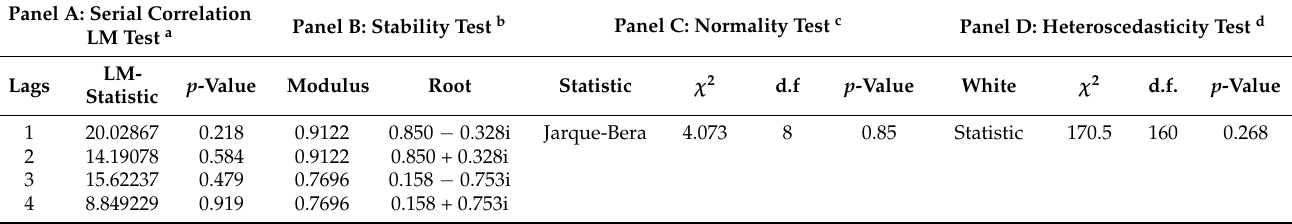
Table 3. The VAR residual